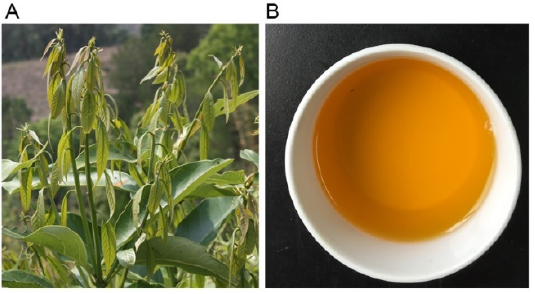
Figure 1. The buds of Castanopsis lamontii ( A ) and its infusion ( B ).